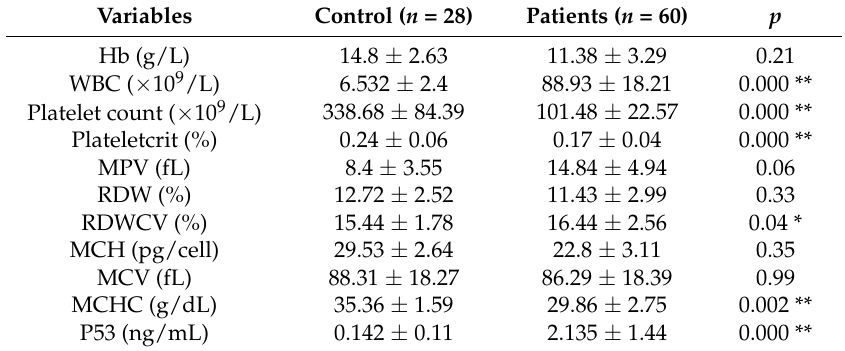
Table 2. The hematological profile and p53 gene level in patients with CML compared to the healthy subjects. Variables